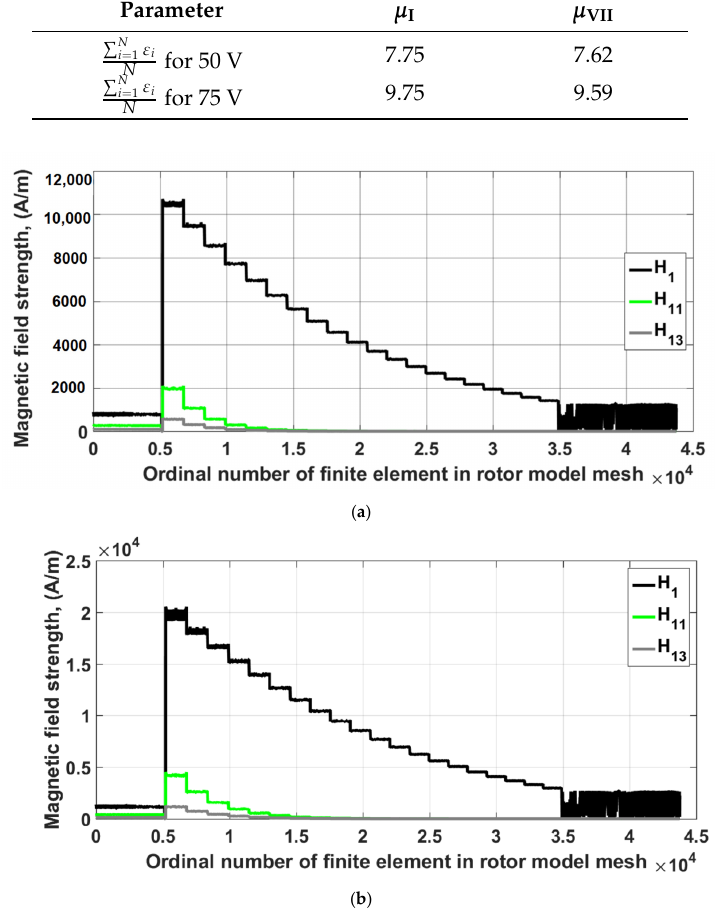
Figure 6. Comparison of the magnetic field strength values in the individual elements creating FE rotor mesh for the rotor models associated with the considered harmonics for a 20% slip: ( a ) at 50 V, ( b ) at 75